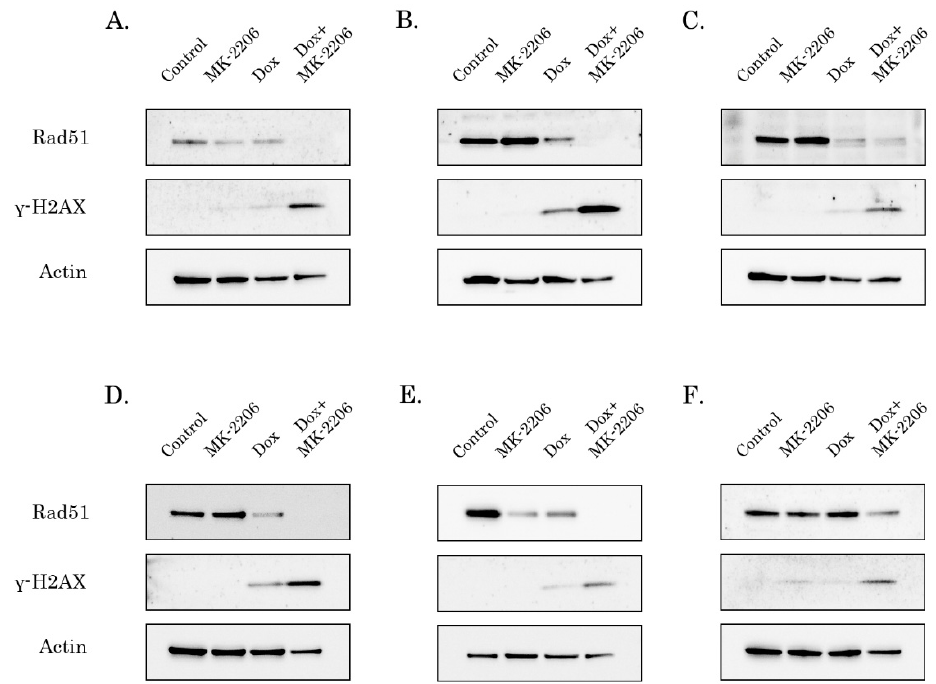
Figure 5. An impact of AKT inhibition on γ -H2AX and Rad51 recombinase in cancer cells. Immunoblot analysis was performed on RD rhabdomyosarcoma ( A ), U2-OS osteosarcoma ( B ), HT-1080 fibrosarcoma ( C ), GIST T-1R ( D ), GIST 430 ( E ), SK-LMS-1 leiomyosarcoma and ( F ) treated with DMSO (control), Dox (0.25 g / mL), MK-2206 (5 M) alone and in combination (e.g., Dox + MK-2206) for 48–72 h. Actin was used as a loading control.